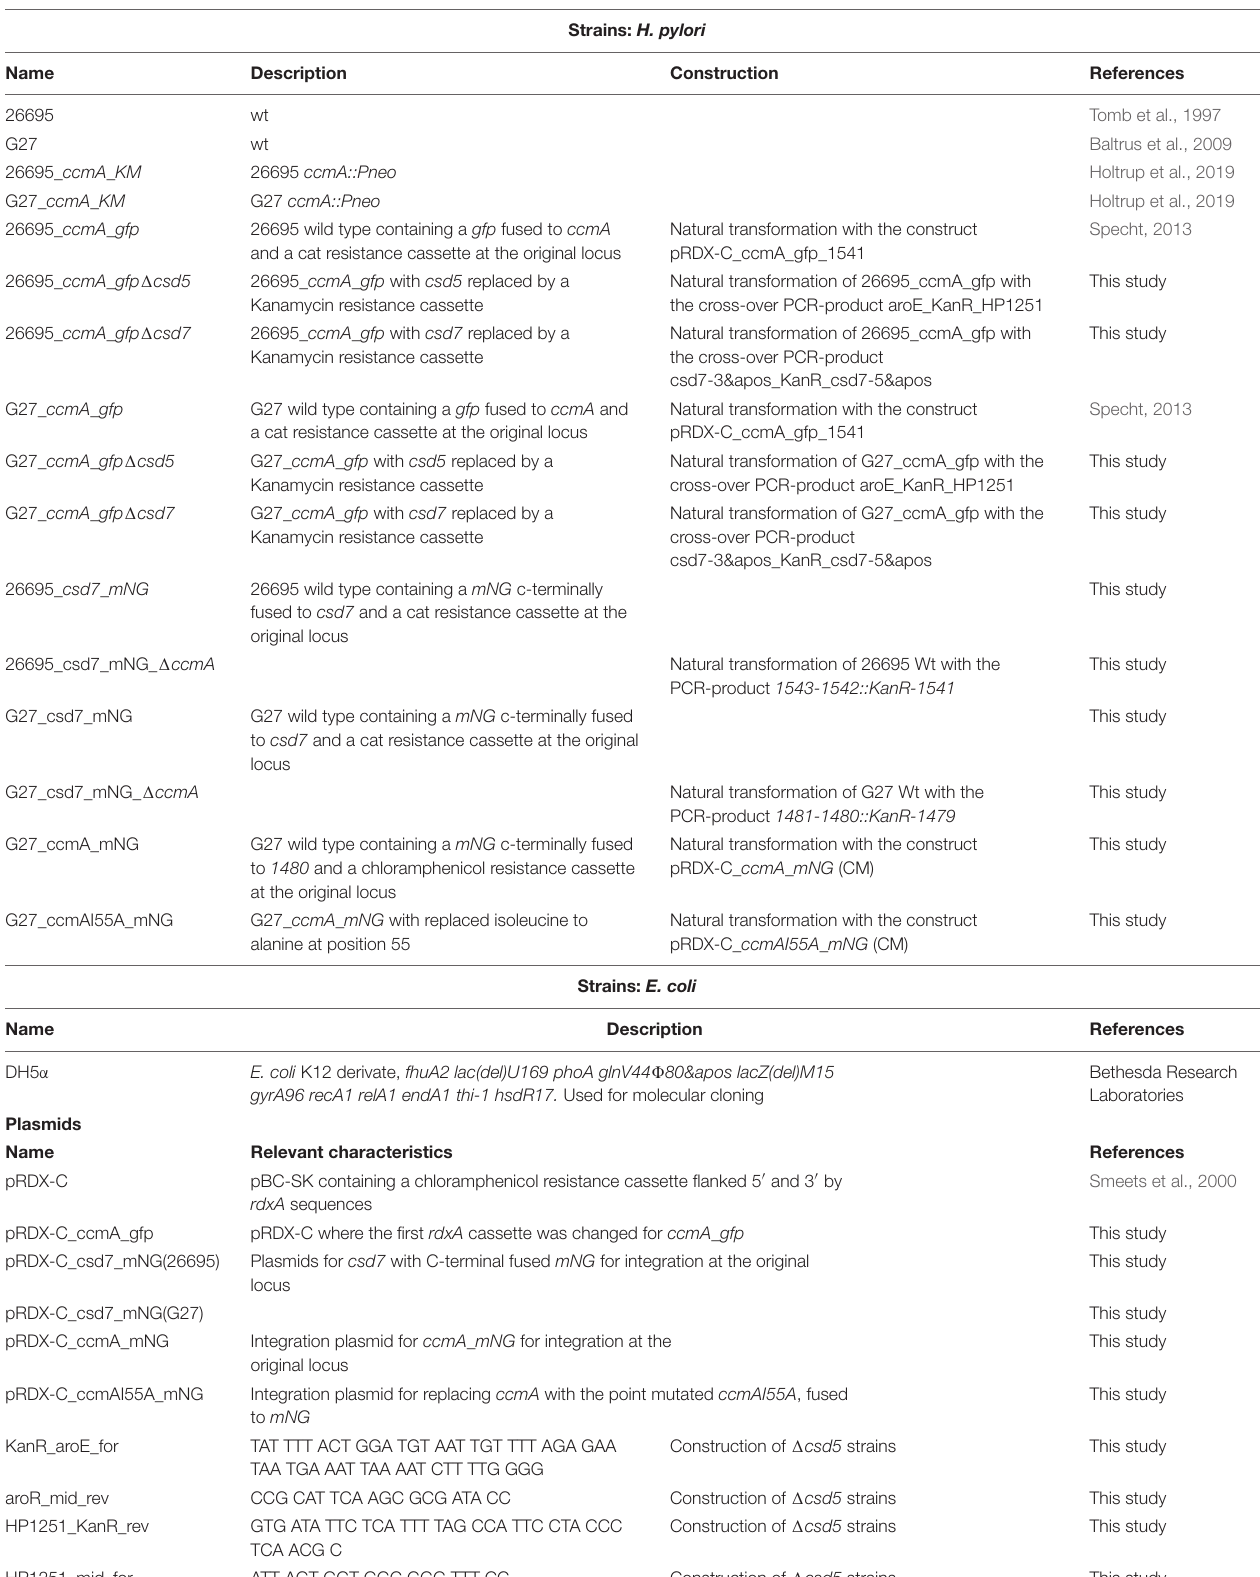
TABLE 6 | List of strains, primers, and plasmids used in this study.